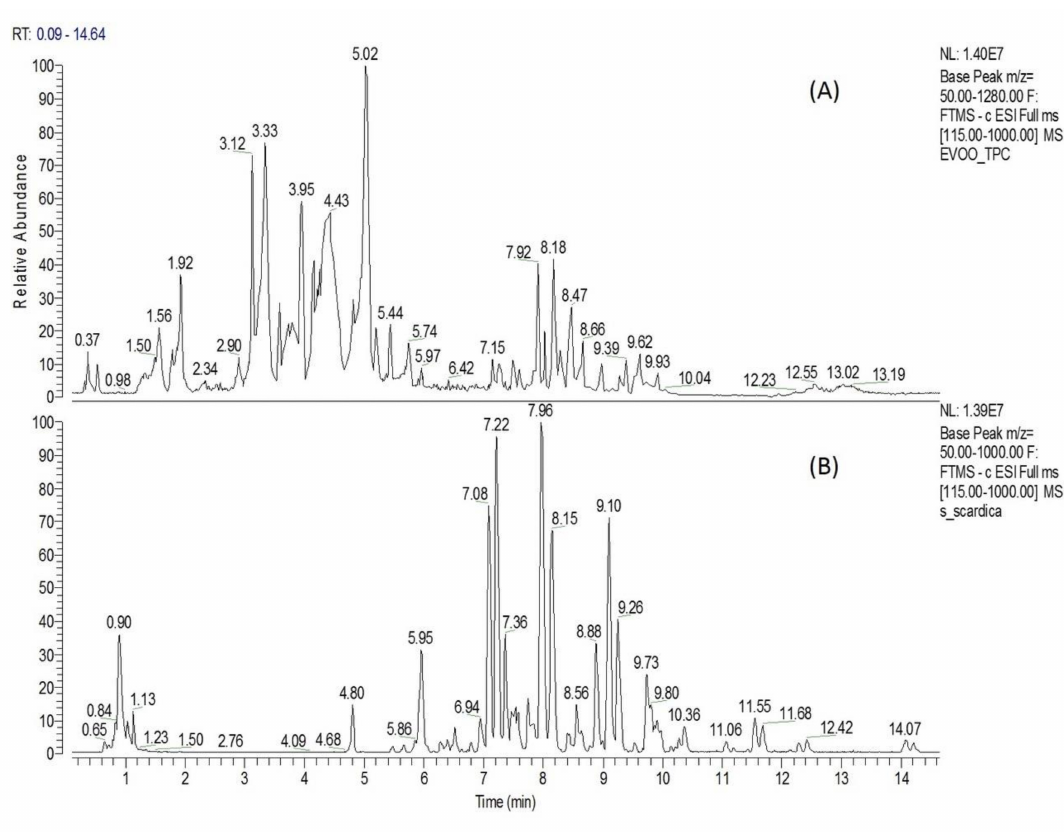
Figure 1. Extracts analysis. Liquid Chromatography-High Resolution Mass Spectrometry (UPLC-ESD-HRMS) chromatogram of extra virgin olive oil biophenolic fraction (TPC) ( A ) and S. scardica hydroaloholic extract (SID) ( B